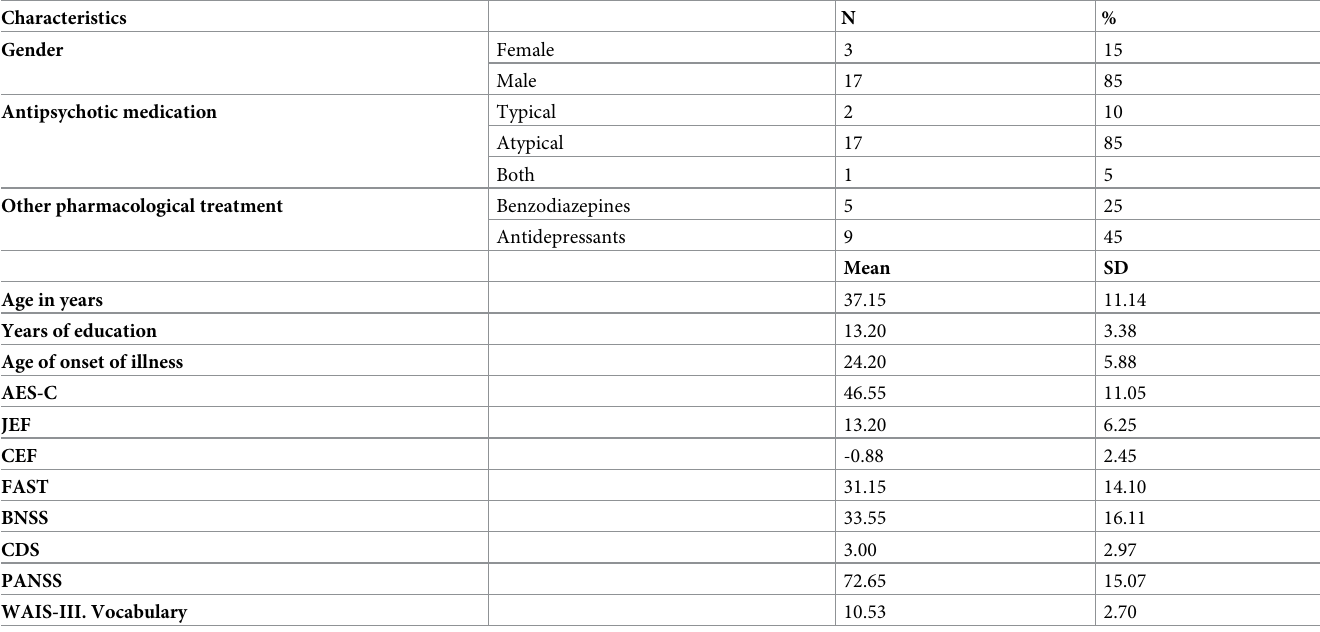
Table 1. Sociodemographic and clinical data from the sample.